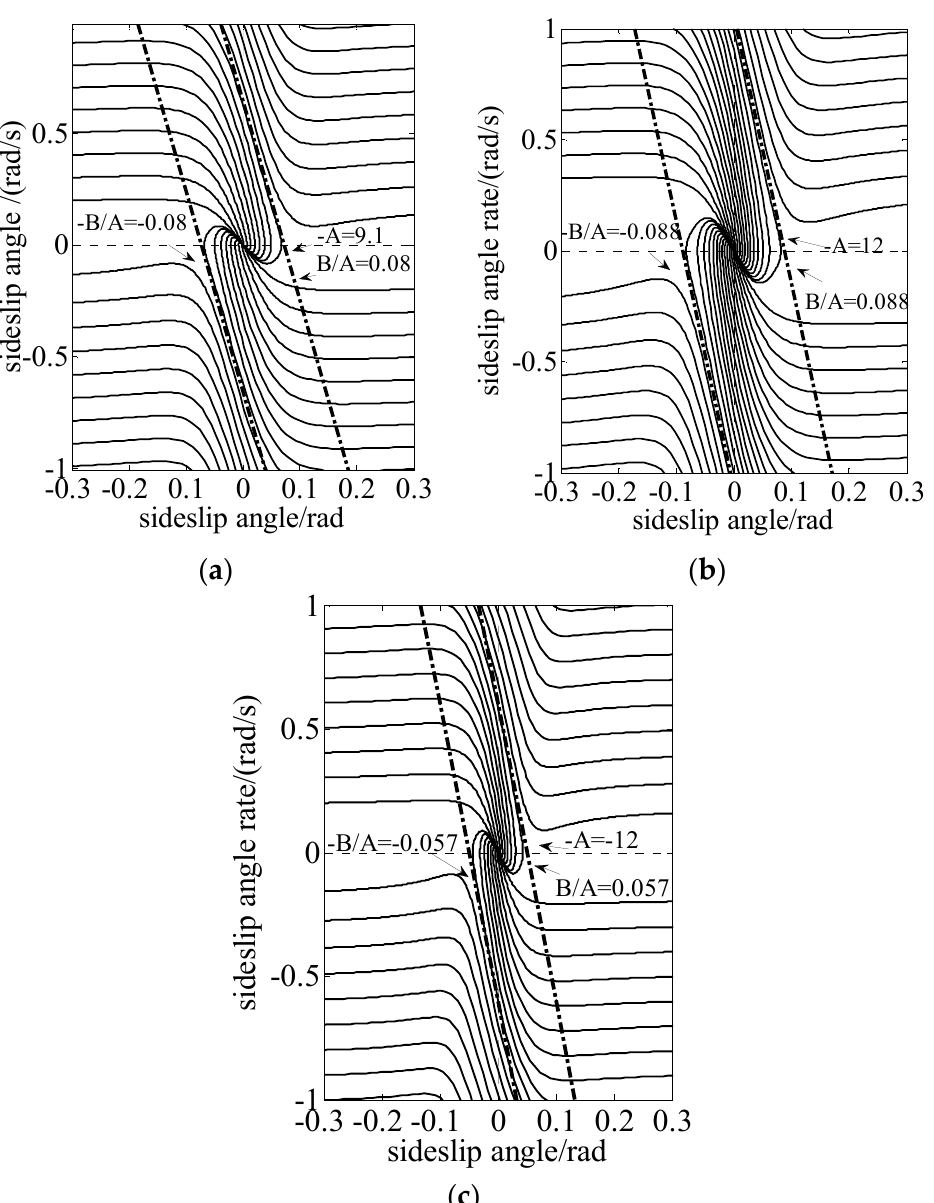
Figure 2. Phase plane in different driving conditions ( a ) V x = 120 km/h, μ = 0.8; ( b ) V x = 80 km/h, μ = 0.8; and ( c ) V x = 80 km/h, μ = 0.5.